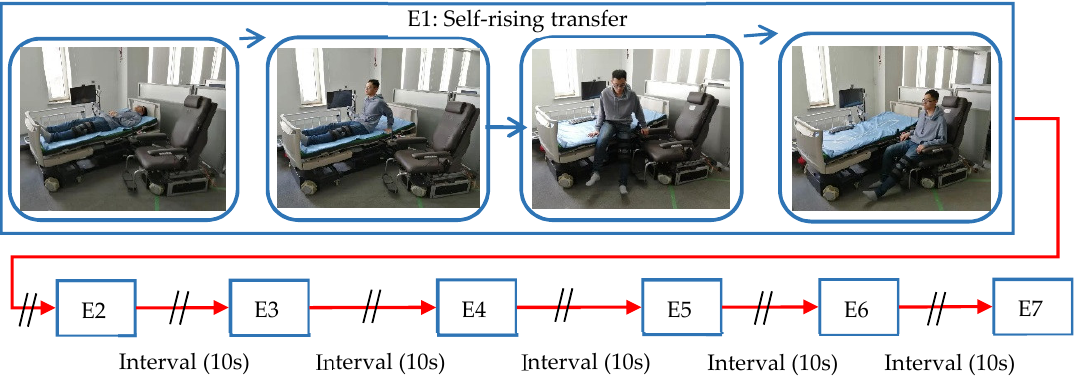
Figure 4. Experiments conducted: a total of 7 group experiments were performed by subjects with 10 s intervals.